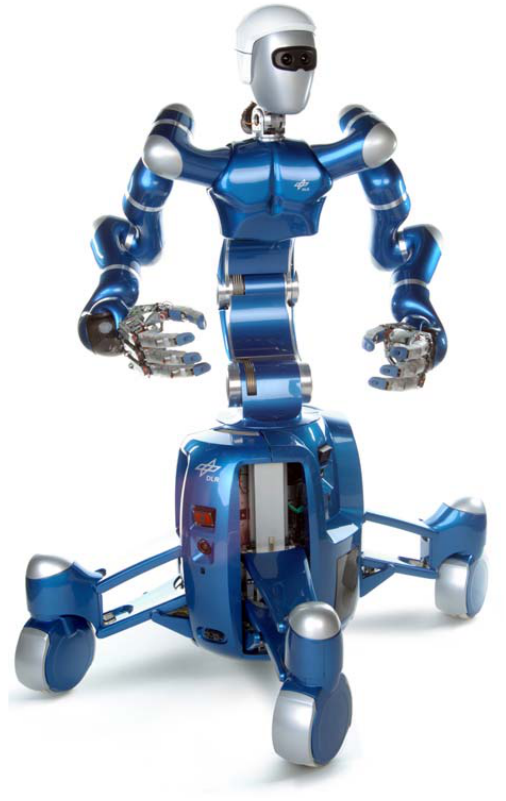
Figure 3. An example of a flexible-base robot: Rollin’ Justin – a robot with a humanoid upper body mounted on a wheeled mo- bile base with flexible suspension (Courtesy of DLR – the German Aerospace Center, Borst et al., 2009).